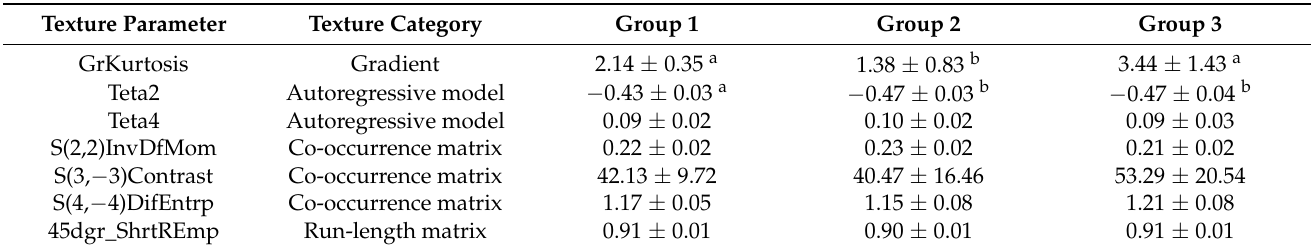
Table 2. Mean ± standard deviation of the absolute values of the texture parameters included in the regression equation for the three different groups (Group 1: IMF ≤ 4.24%; Group 2: 4.25% ≤ IMF ≤ 5.75%; and Group 3: IMF > 5.76%). The category for each texture parameter is also